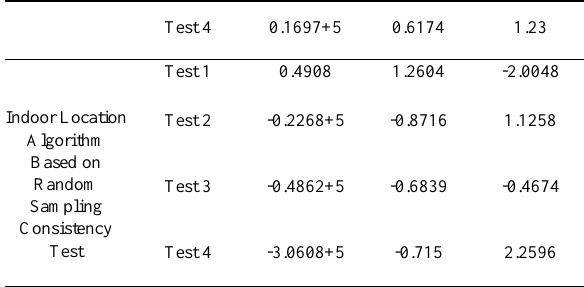
Table 5 Two algorithms simulate positioning results (add noise in the data) Description: The bold font in the table indicates the artificially added new